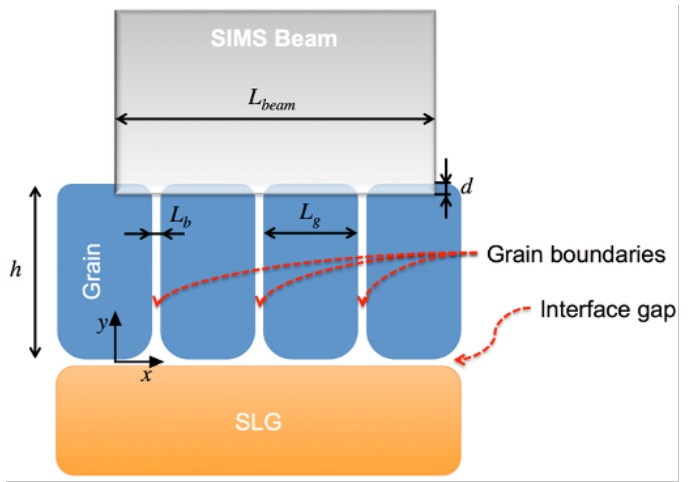
Figure 2. Schematic of SIMS beam sputtering molybdenum grains and grain boundaries on a SLG substrate. © (2017) IEEE. Reprinted, with permission, from 2017 IEEE 44th PVSC Proceedings